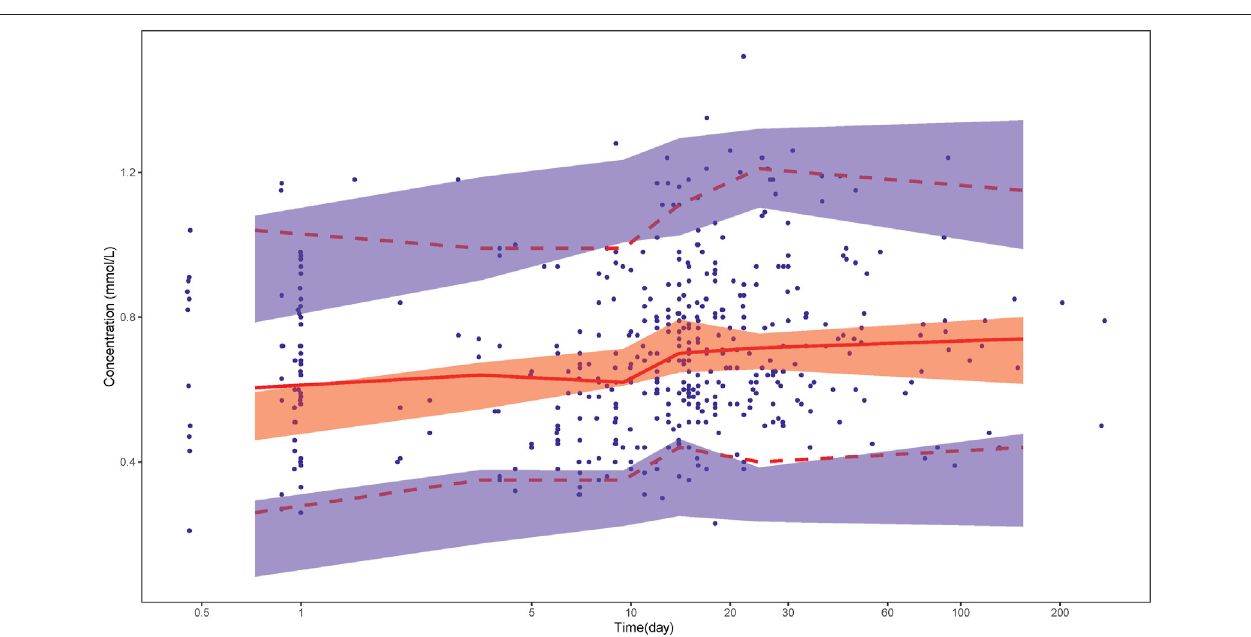
FIGURE 2 | Visual predictive check. Solid dots represent observed data. Lines represent the 5% (dashed), 50% (solid), and 95% (dashed) percentiles of the observed data. Shaded areas represent nonparametric 95% con fi dence intervals about the 5% (light blue), 50% (light red), and 95% (light blue) percentiles of the predicted